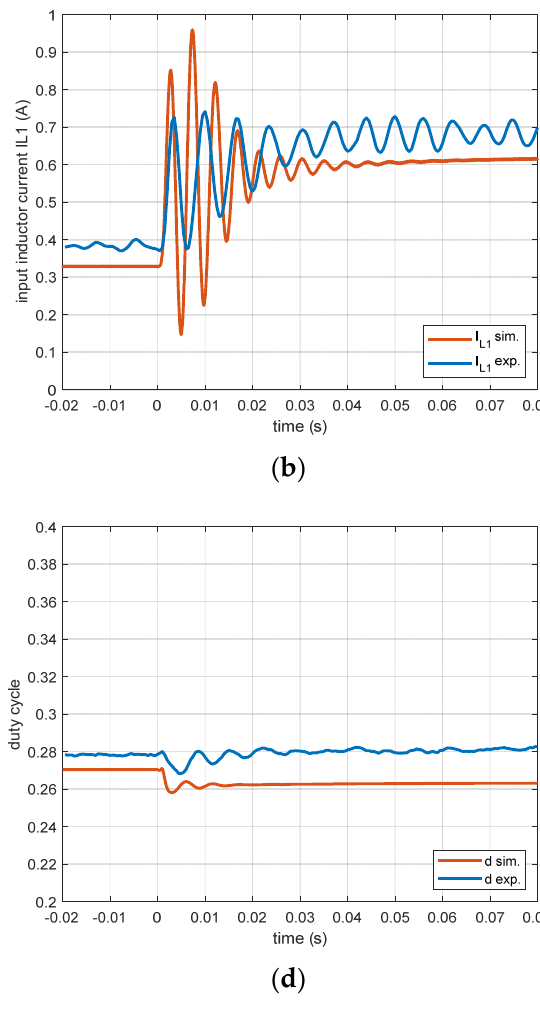
Figure 12. Simulation and experimental results in Scenario #3 (SD − GD): ( a ) grid − side currents; ( b ) input inductor current; ( c ) grid voltage variation; ( d ) duty cycle.